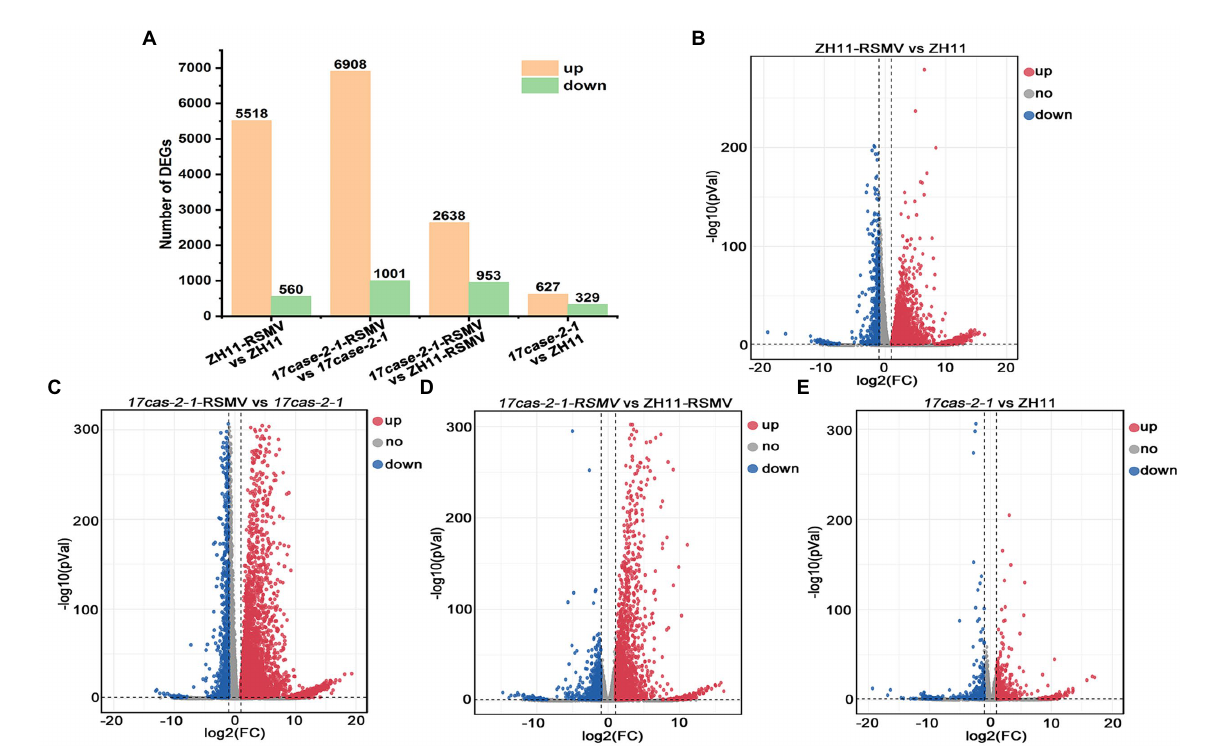
FIGURE 2 Differentially expressed genes (DEGs) of the rice in response to RSMV analysis. (A) Number of differentially expressed genes (DEGs) in ZH11–RSMV vs. ZH11 (RSMV-infected ZH11 plants compared to ZH11 control plants); 17cas-2-1 -RSMV vs. 17cas-2-1 (RSMV-infected 17cas-2-1 plants compared to 17cas-2-1 plants); 17cas-2-1 -RSMV vs. ZH11-RSMV (RSMV-infected 17cas-2-1 plants compared to RSMV-infected ZH11 plants); 17cas-2-1 vs. ZH11( 17cas-2-1 plants compared to ZH11 control plants). (B) The volcano map of differentially expressed genes in ZH11-RSMV vs. ZH11. (C) The volcano map of differentially expressed genes in 17cas-2-1 -RSMV vs. 17cas-2-1. (D) The volcano map of differentially expressed genes in 17cas-2-1- RSMV vs. ZH11-RSMV. (E) The volcano map of differentially expressed genes in 17cas-2-1 vs. ZH11. Red dots represent up-regulated significantly differentially expressed genes, blue dots represent down-regulated significantly differentially expressed genes, and grey dots represent no significant differences,